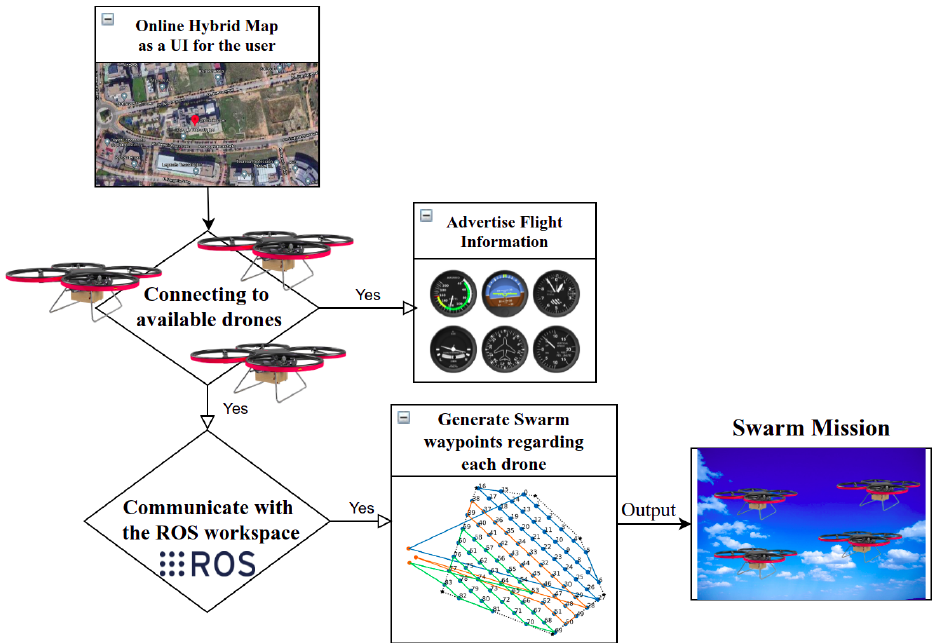
Figure 6. A diagram of the swarm mission